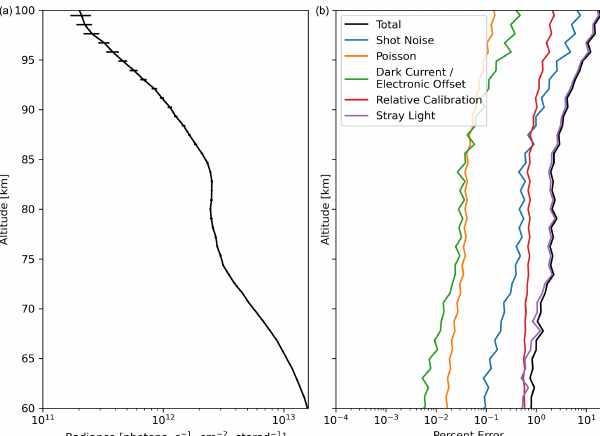
Figure 1. (a) A sample daytime exposure of IRI radiance data (im- age 1250 of orbit 37400; see Fig. 4 for reference). (b) The corre- sponding total calibration random error and its